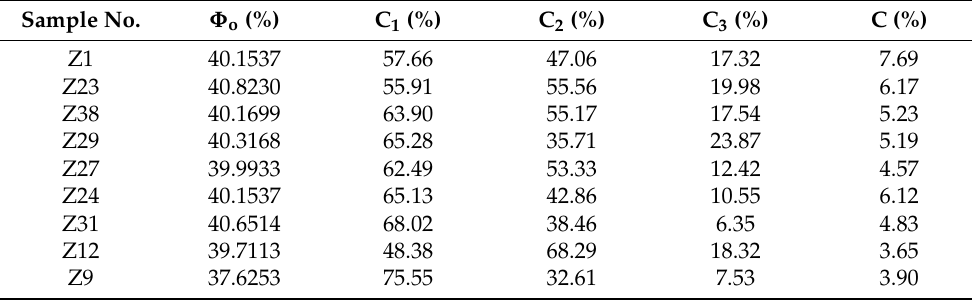
Table A3. The initial porosity and four diagenesis indicators of deep-mine sandstone. Sample